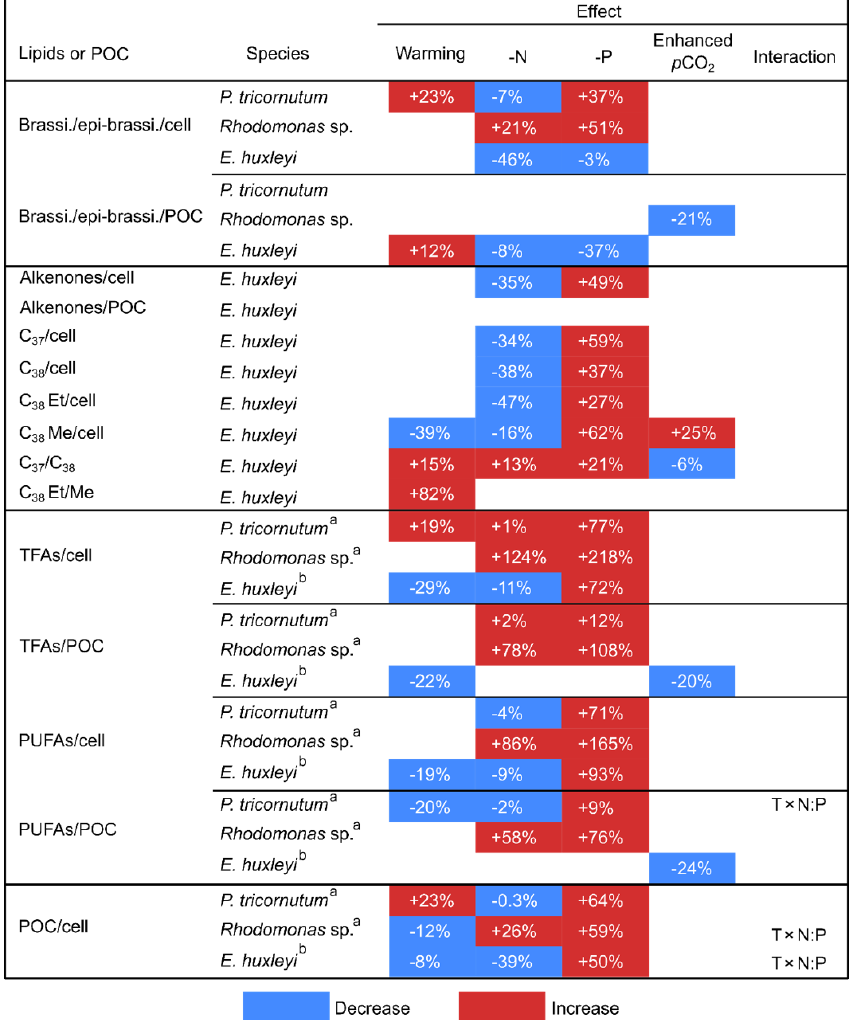
Table 2. The mean percent differences in carbon-normalized and per-cell contents of brassicasterol / epi-brassicasterol (brassi. / epi- brassi. / POC and brassi. / epi-brassi. / cell; µgmgC − 1 and pgcell − 1 ), total fatty acids (TFAs / POC and TFAs / cell), polyunsaturated fatty acids (PUFAs / POC and PUFAs / cell), and per-cell contents of particulate organic carbon (POC / cell) in Phaeodactylum tricornutum , Rhodomonas sp., and Emiliania huxleyi ; carbon-normalized and per-cell contents of total alkenones (Alkenones / POC and Alkenones / cell), and per-cell contents of C 37 alkenones (C 37 / cell), C 38 alkenones (C 38 / cell), C 38 ethyl ketones (C 38 Et / cell), and C 38 methyl ketones (C 38 Me / cell) in E. huxleyi ; C 37 / C 38 alkenone ratios (C 37 / C 38 ) and C 38 ethyl / C 38 methyl ratios (C 38 Et / Me) in E. huxleyi between cold and warm treatments, under N and P deficiency (-N and -P) and enhanced p CO 2 conditions. Only significant changes are shown according to GLMMs (Table